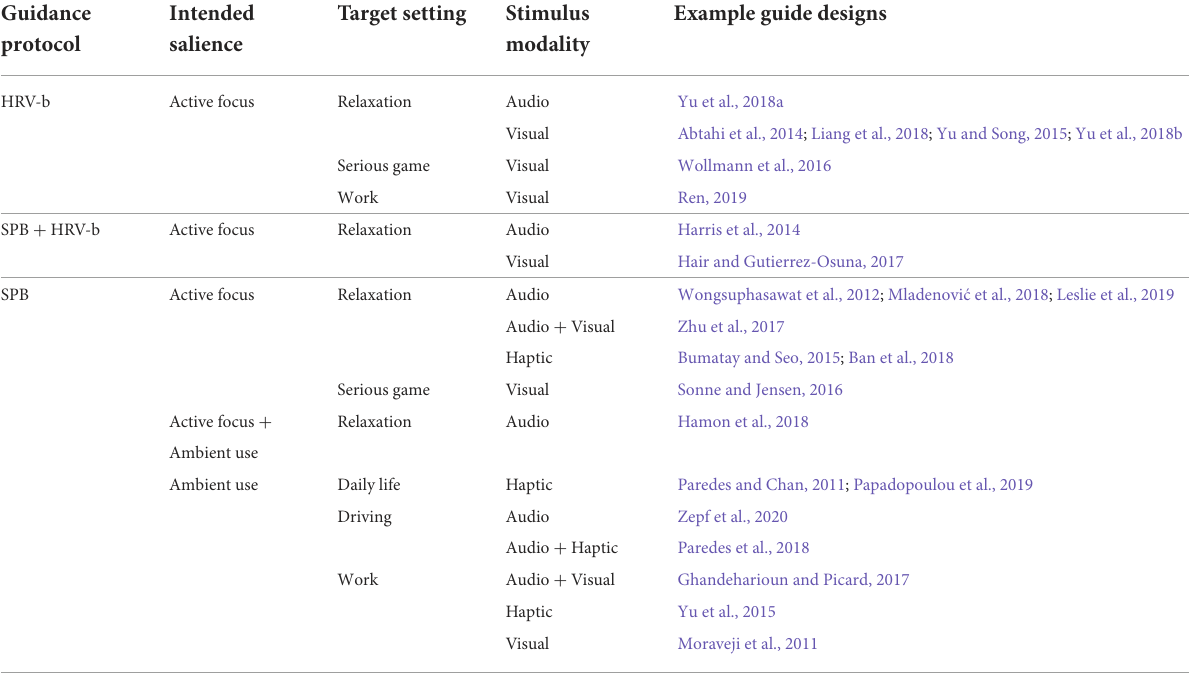
TABLE 1 An illustrative sample of existing guided breathing technology designs.